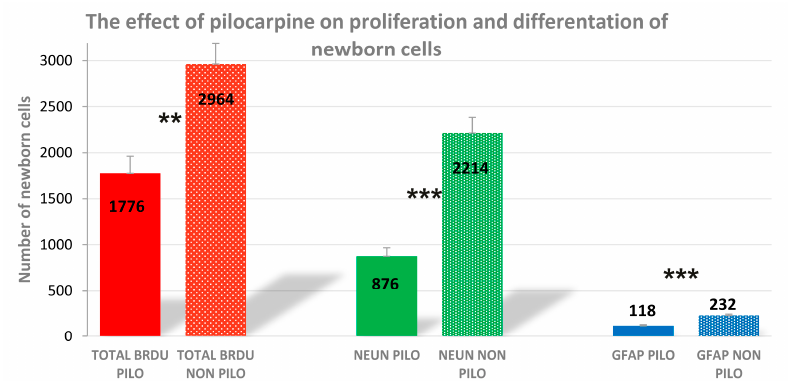
Figure 1. The numbers of cells represent an estimate of the total number of positively labeled cells in the subgranular zone in both hemispheres. The results were analyzed using Student’s t -test. Each bar represents the mean for five mice; error bars are the standard error of the mean (S.E.M., ** p < 0.01; *** p < 0.001).